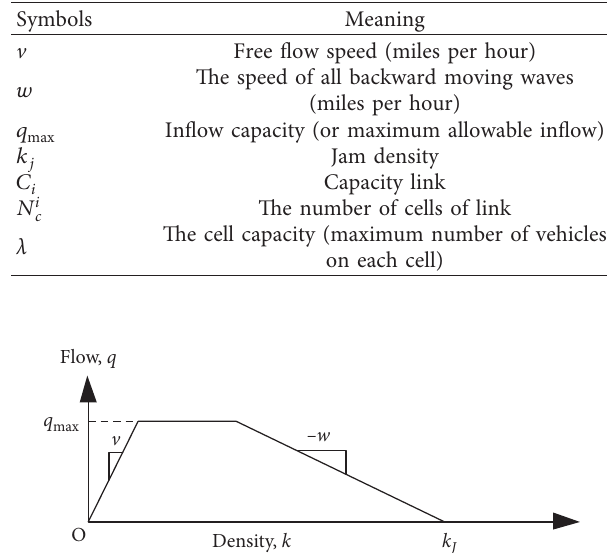
Table 1: Symbols used in this paper.